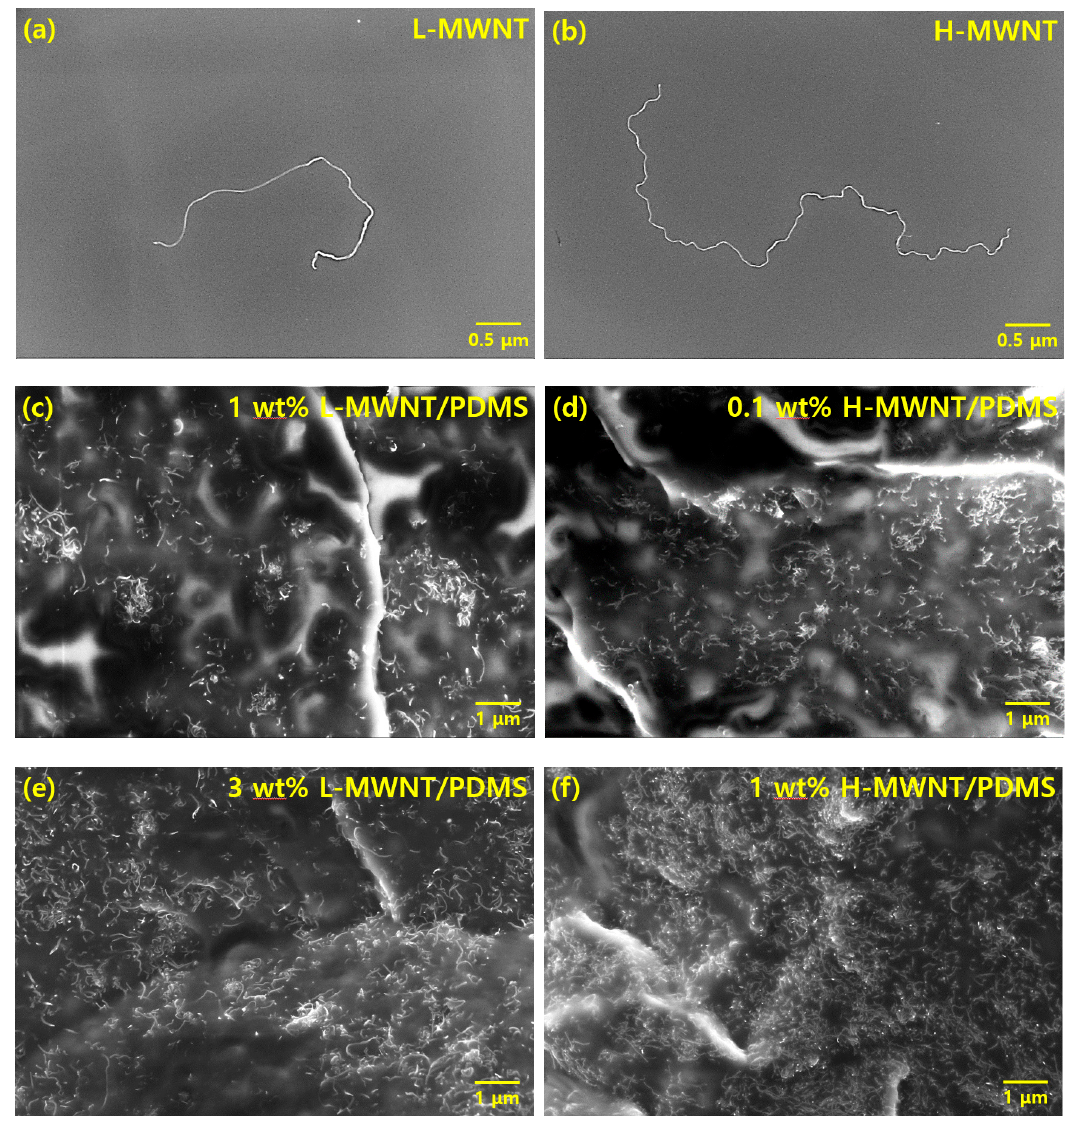
Figure 2. SEM images of MWNTs: ( a ) low-aspect-ratio MWNT (L-MWNT); ( b ) high-aspect-ratio MWNT (H-MWNT); and cross-section of MWNTs/PDMS composites: ( c ) 1 wt.% L-MWNT/PDMS; ( d ) 0.1 wt.% H-MWNT/PDMS; ( e ) 3 wt.% L-MWNT/PDMS; and ( f ) 1 wt.% H-MWNT/PDMS.